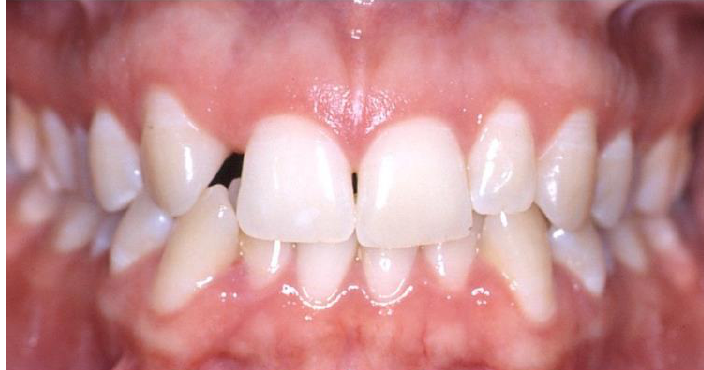
Figure 1. Monolateral agenesis of maxillary right lateral incisor.